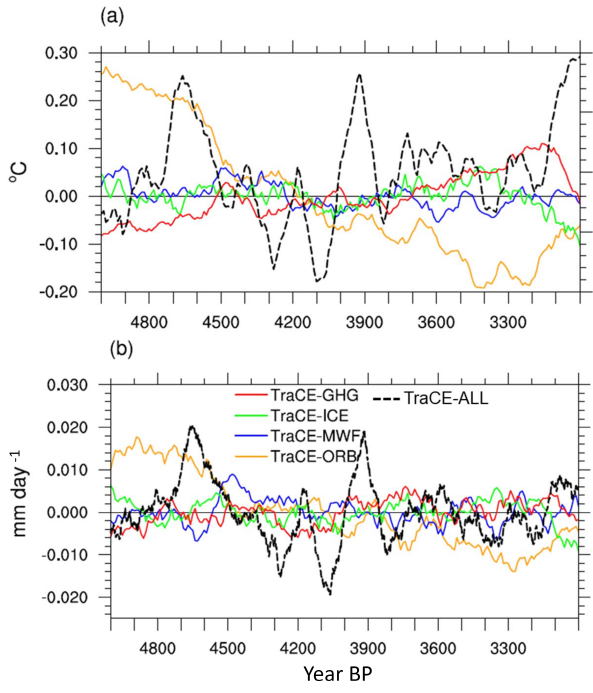
anomalies and (b) precipitation anomalies derived from the TraCE- ALL run (dashed black lines) and each single-forcing run (solid color lines) from 5 to 3ka. A 101-year running mean has been ap- plied to the time